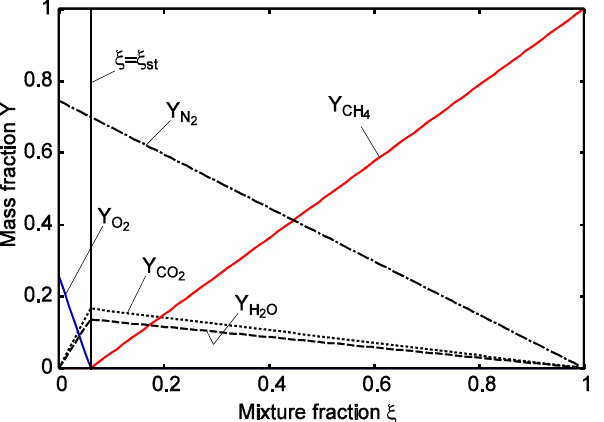
Figure 13. Mass fraction profiles of each chemical species against mixture fraction ξ for methane and air